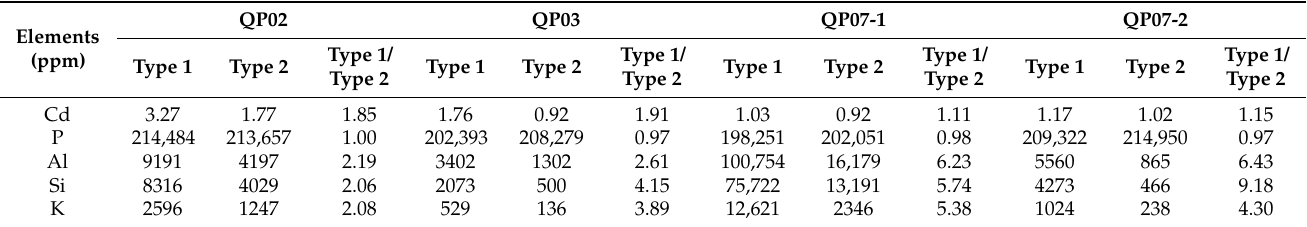
Table 4. Contents of major and trace elements in different regions of